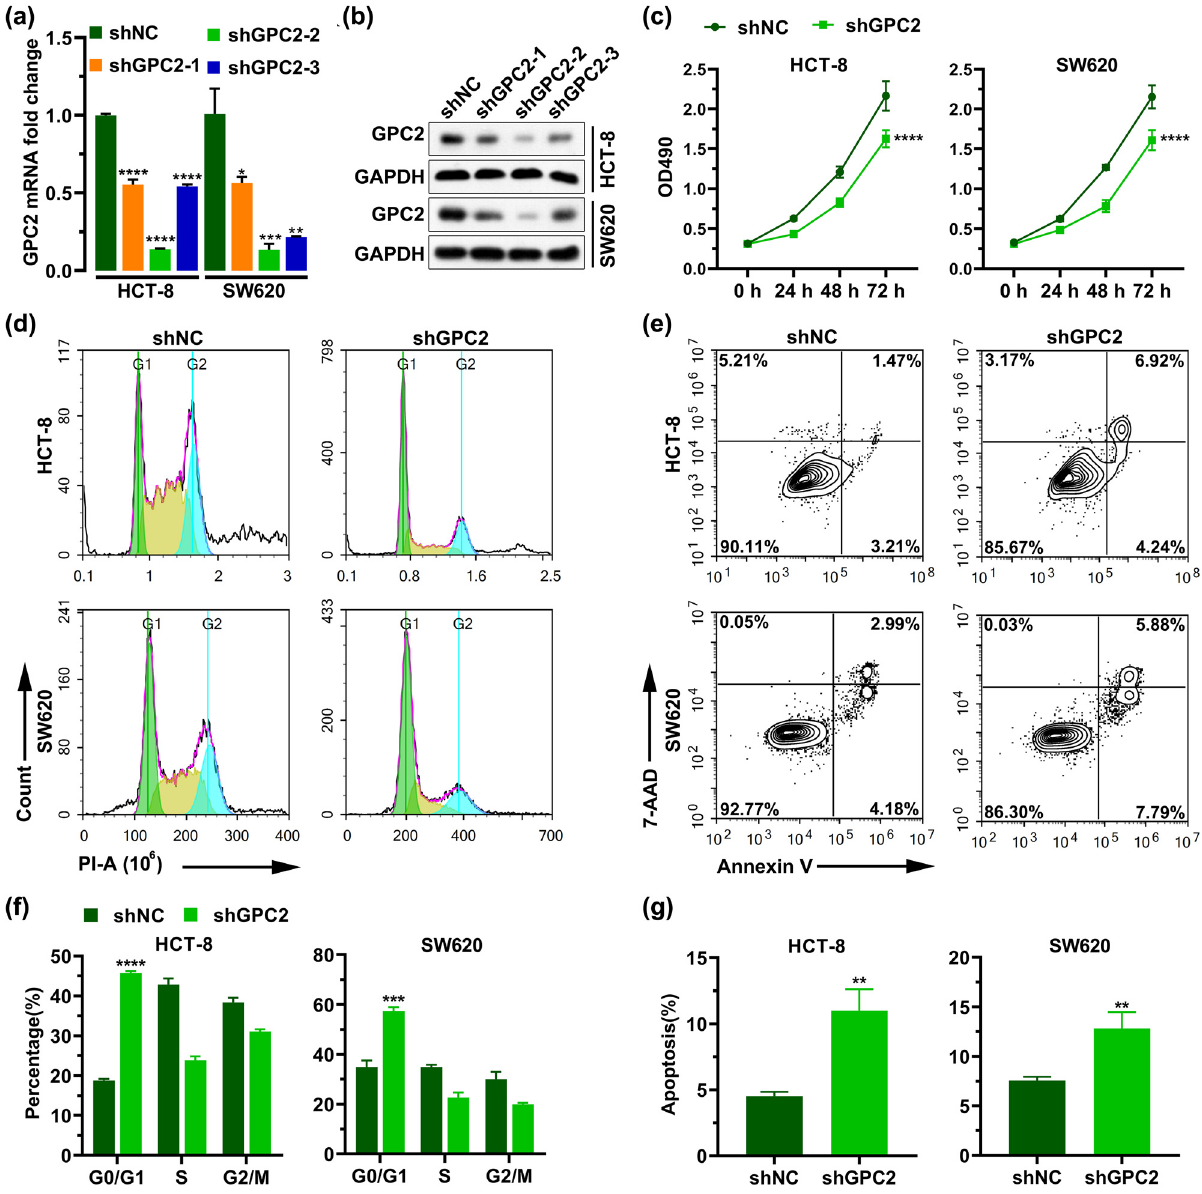
Figure 5: Decreasing GPC2 inhibits proliferation and promotes apoptosis in HCT - 8 and SW620 cells: ( a and b ) after transfection of shNC, shGPC2 - 1, shGPC - 2, and shGPC2 - 3 in HCT - 8 and SW620 cells, the level of GPC2 was detected by RT - PCR ( a; n = 3 ) and ( b ) Western blotting, ( c ) MTT assay was used to analyze the e ff ect of silencing GPC2 on cell proliferation ( n = 6 ) , ( d and f ) Flow cytometry was used to analyze the cell proportion of di ff erent cell cycles after GPC2 silencing ( n = 3 ) , ( e and g ) Annexin V/7 - AAD Apoptosis Kit was used to detect the proportion of apoptosis in HCT - 8 and SW620 cells after GPC2 silencing ( n = 3 ) . * P < 0.05, ** P < 0.01, *** P < 0.001, **** P <